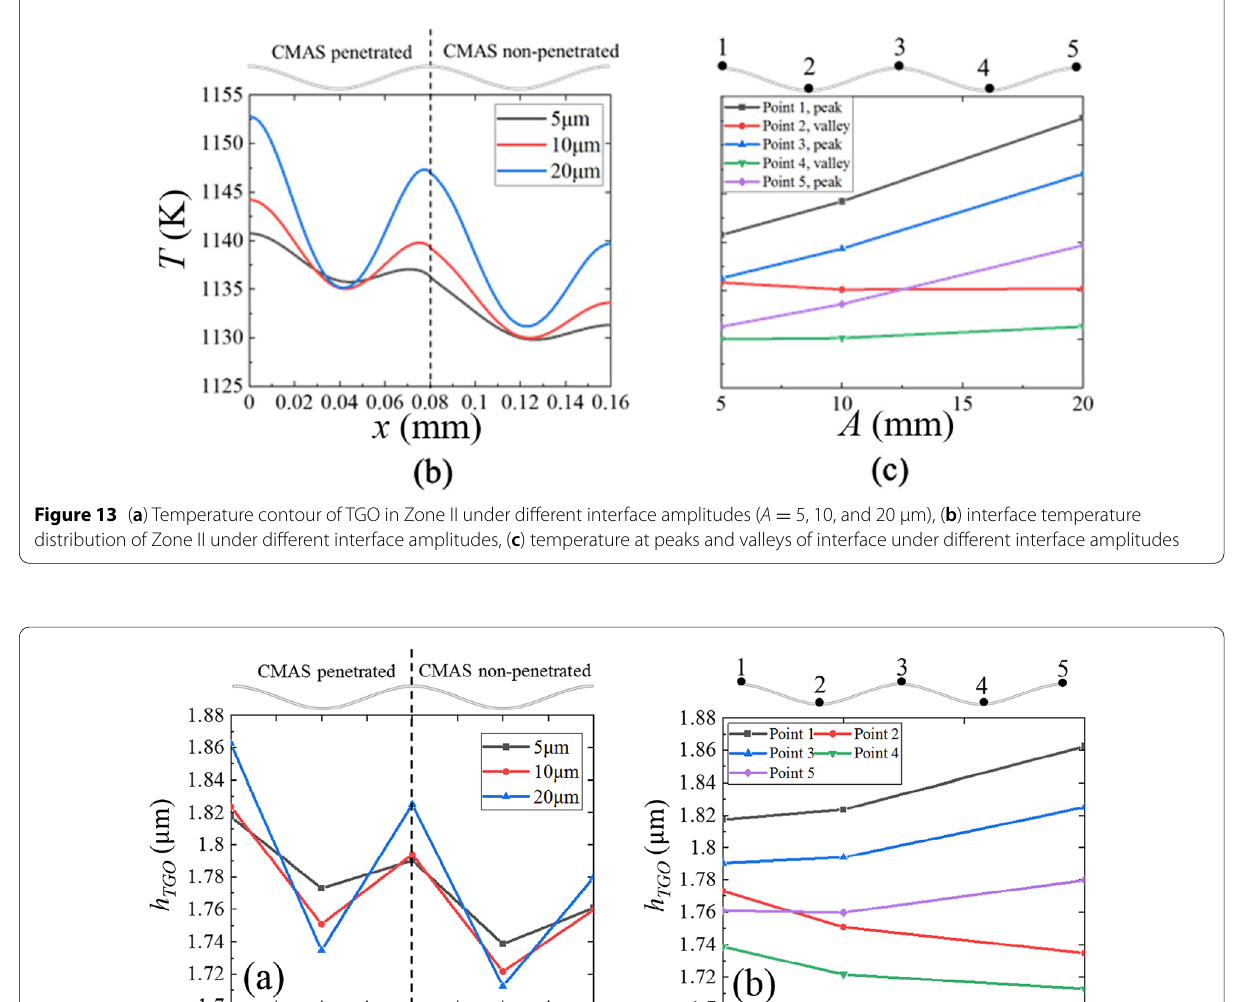
Figure 14 ( a ) Distribution of TGO thickness for different interface amplitudes, ( b ) TGO thickness at peaks and valleys of interface vs. interface